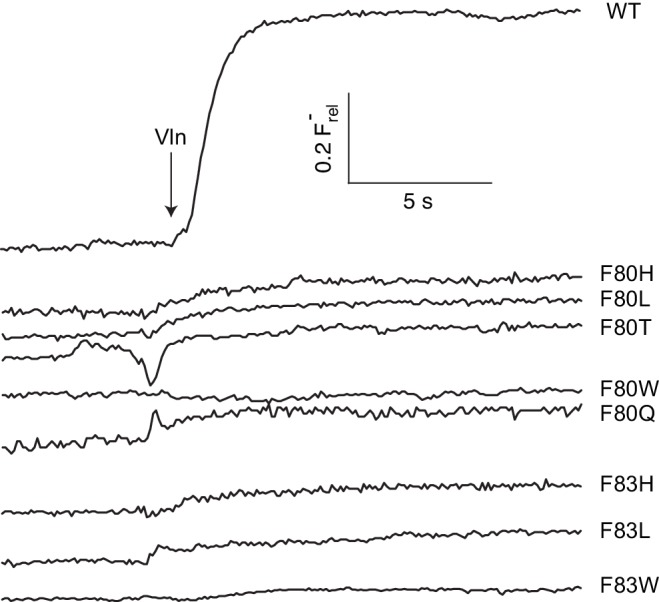
F- efflux recordings of central Phe mutants.